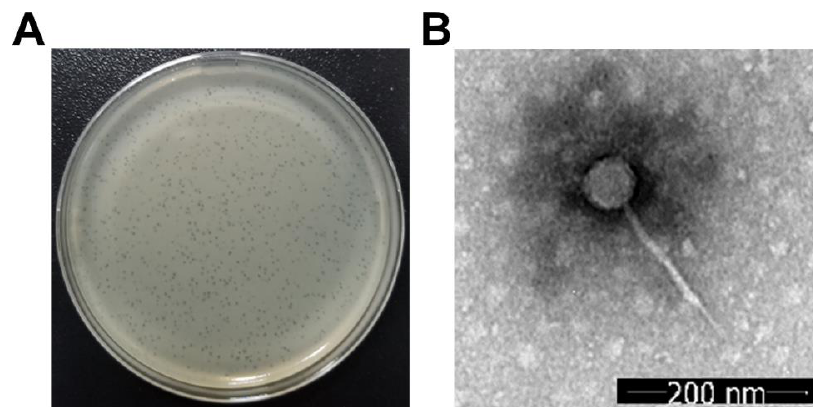
Figure 1. Morphological observation of the vB_KleS-HSE3 phage. ( A ) The plaques formed by the phage on the bacterial lawn of K. pneumoniae strain 1025. ( B ) Virion morphology of the phage observed by TEM.